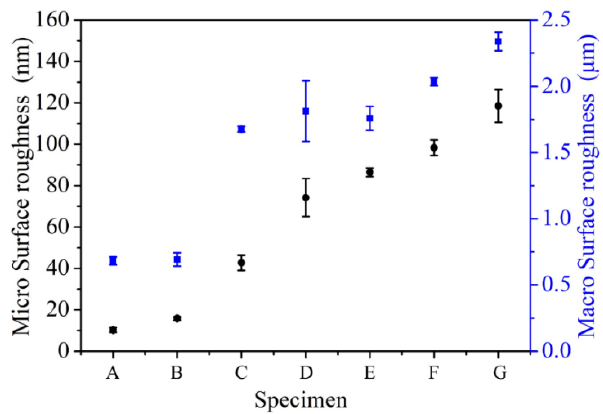
Figure 2. Surface roughness of the specimen A – G were evaluated via AFM, and LSCM after